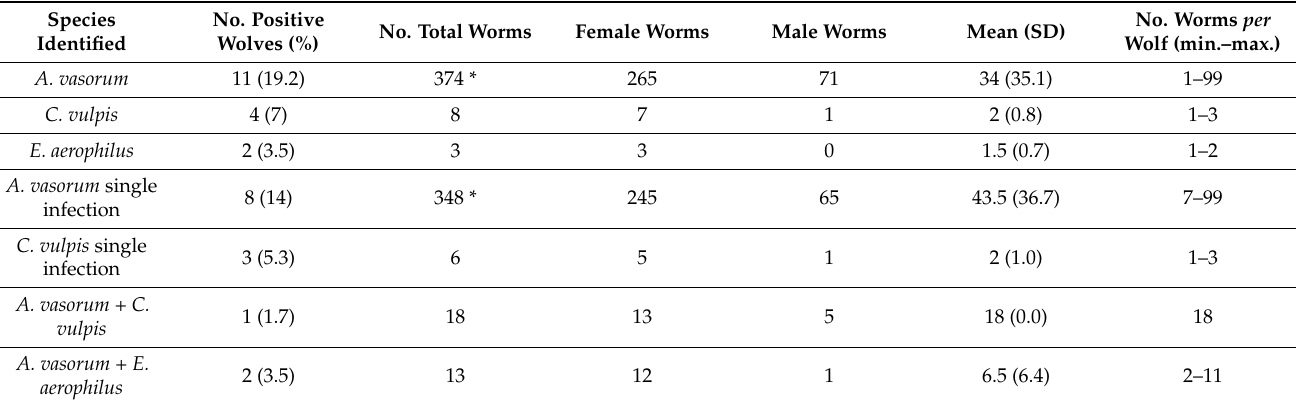
Table 1. Numbers of cardiorespiratory nematodes collected from 14 infected Iberian wolves from northwestern Spain according to the species